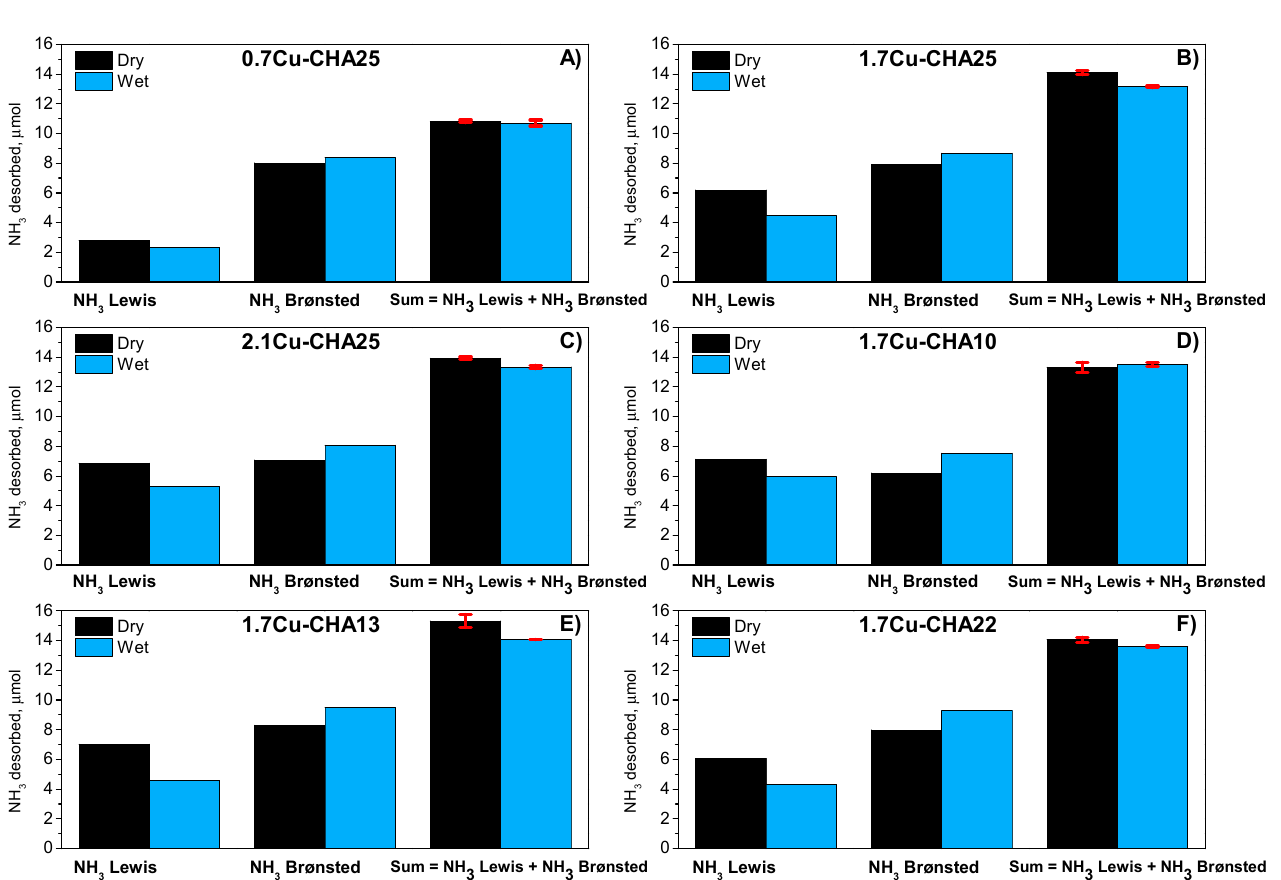
Figure 5. Deconvolution of the TPD profiles: evaluation of NH 3 stored on Lewis and Brønsted sites. Comparison between dry and wet conditions over different Cu-CHA samples: ( A ) 0.7% w / w Cu, SAR = 25; ( B ) 1.7% w / w Cu, SAR = 25; ( C ) 2.1% w / w Cu, SAR = 25; ( D ) 1.7% w / w Cu, SAR = 10; ( E ) 1.7% w / w Cu, SAR = 13; ( F ) 1.7% w / w Cu, SAR = 22. NH 3 = 500 ppm, H 2 O = 0–5% v / v , He. GHSV = 266,250 cm 3 /(g cat *h) (STP). Pre-oxidized catalysts. Red symbols = Error bar.